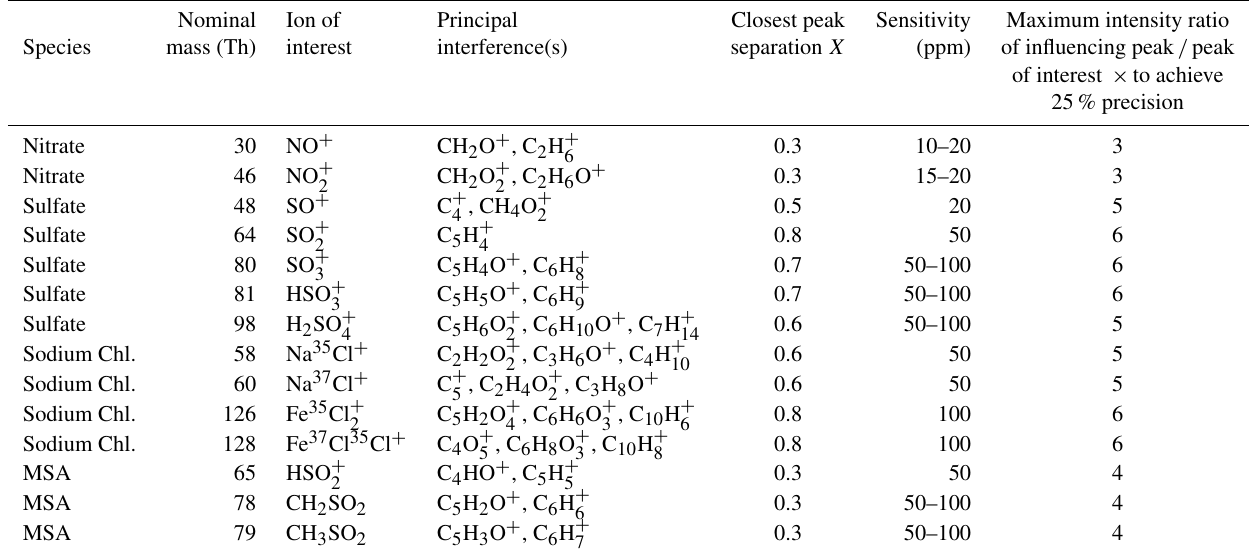
Table 4. Summary of ions of interest, their isobaric interferences and recommended magnitudes for calibration sensitivity analyses for various aerosol species measurable with the ToF-ACSM. Nominal Ion of Principal Closest peak Sensitivity Maximum intensity ratio Species mass (Th) interest interference(s) separation X (ppm) of influencing peak / peak